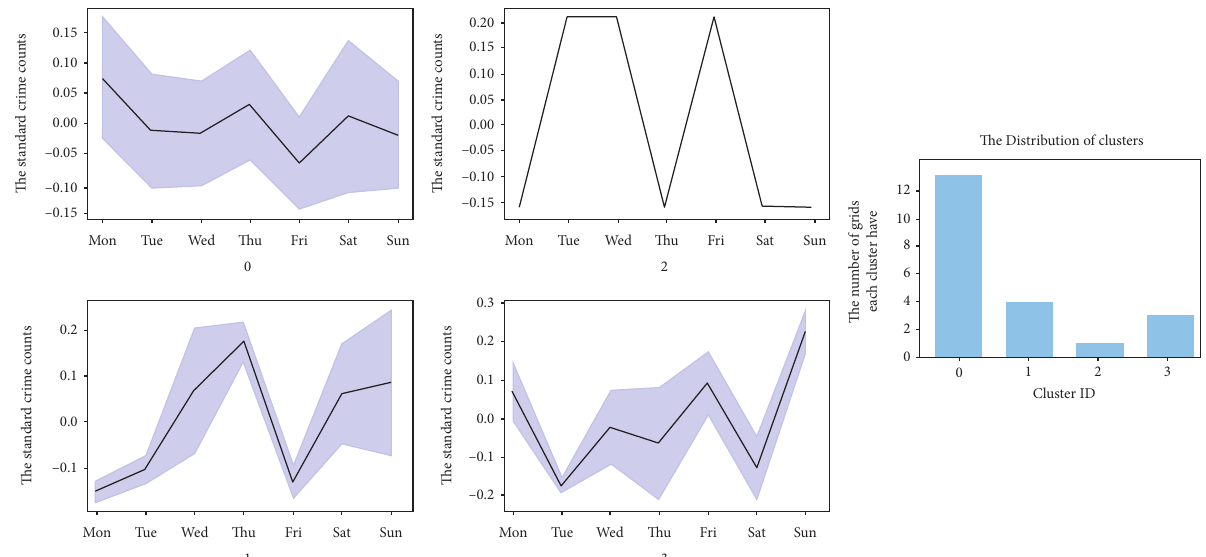
Figure 11: The burglary in Santa Monica trends in the average weeks in 2018 and the distribution of clusters. The line charts are the weekly trends of burglary in Santa Monica in 2018. The bar chart is the distribution of the clusters.